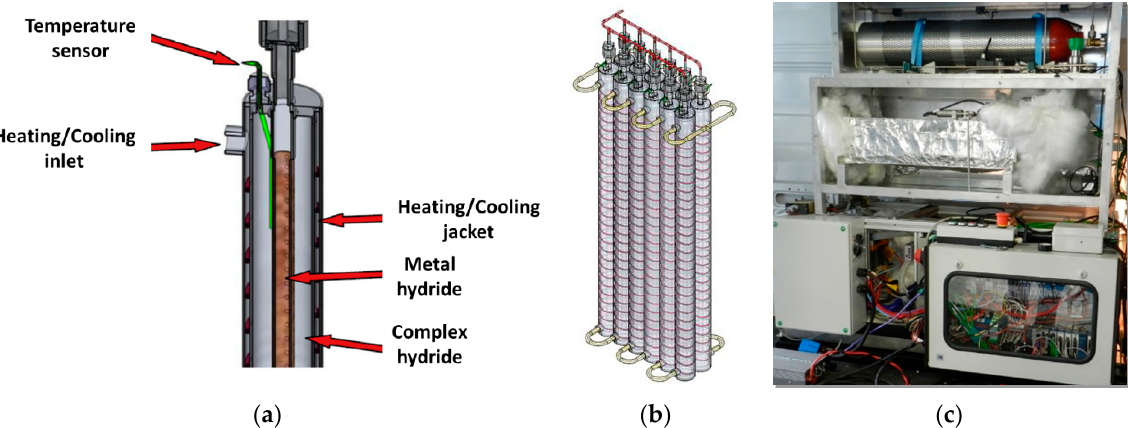
Figure 6. Solid-state hydrogen tank, coupled with a HT-PEM FC to be used as an auxiliary power unit (APU) using a complex hydride as carrier. ( a ) Scheme of single vessel implementing the double storage materials concept (combi-tank); ( b ) assembly of 12 vessels in parallel to form the complete storage system; ( c ) general view of the developed system. Details available in Baricco et al. [162].